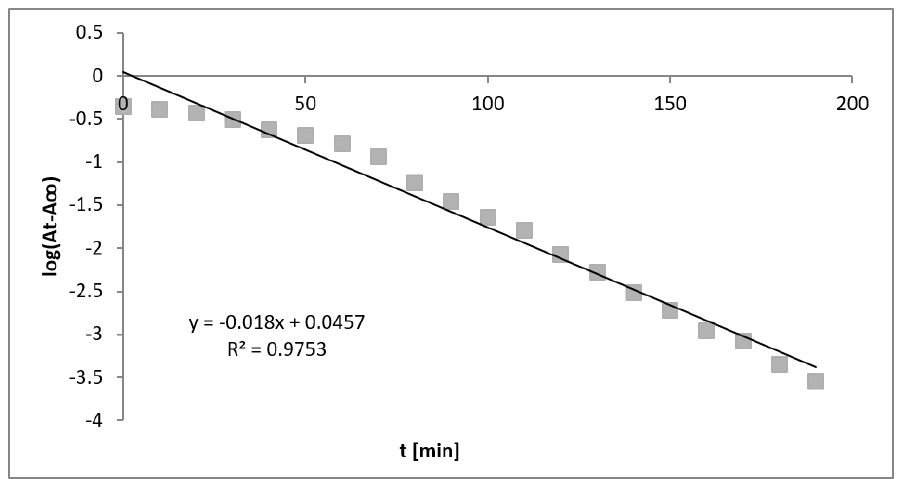
Figure 2. Semilogarithmic plot used to determine rate constants for spontaneous hydrolysis of compound 4c .